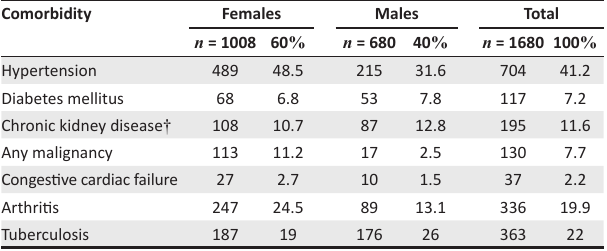
TABLE 2: Distribution of comorbidities amongst elderly patients receiving antiretroviral therapy at Newlands Clinic in March 2020, by sex. Comorbidity